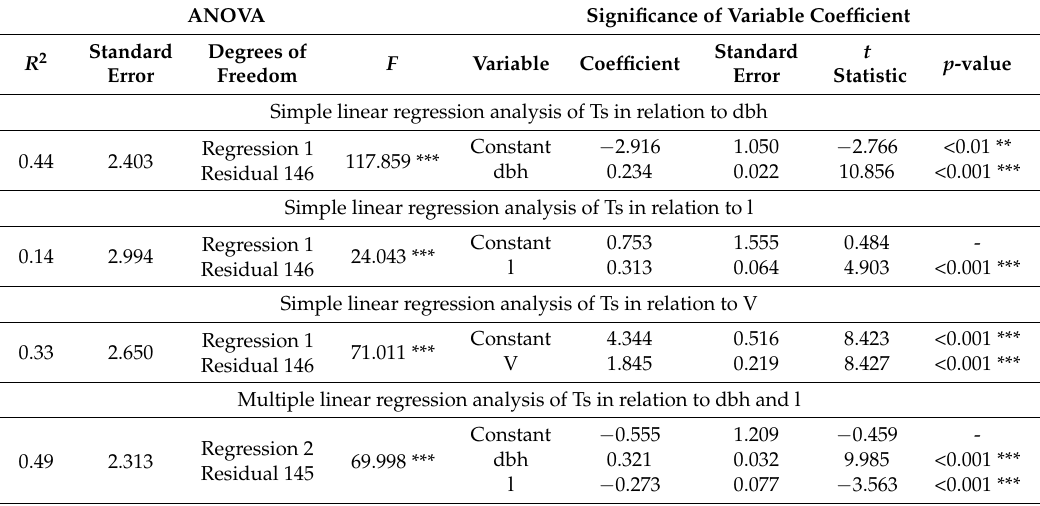
Table 6. Linear regression analysis of the work time consumed for tree cross-cutting in relation to the breast height diameter, stem length, and tree volume.